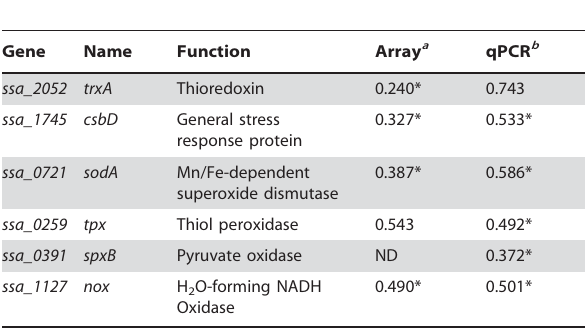
Table 1. Expression ratios of genes in S. sanguinis D spxA1 compared with SK36 by microarray and qPCR